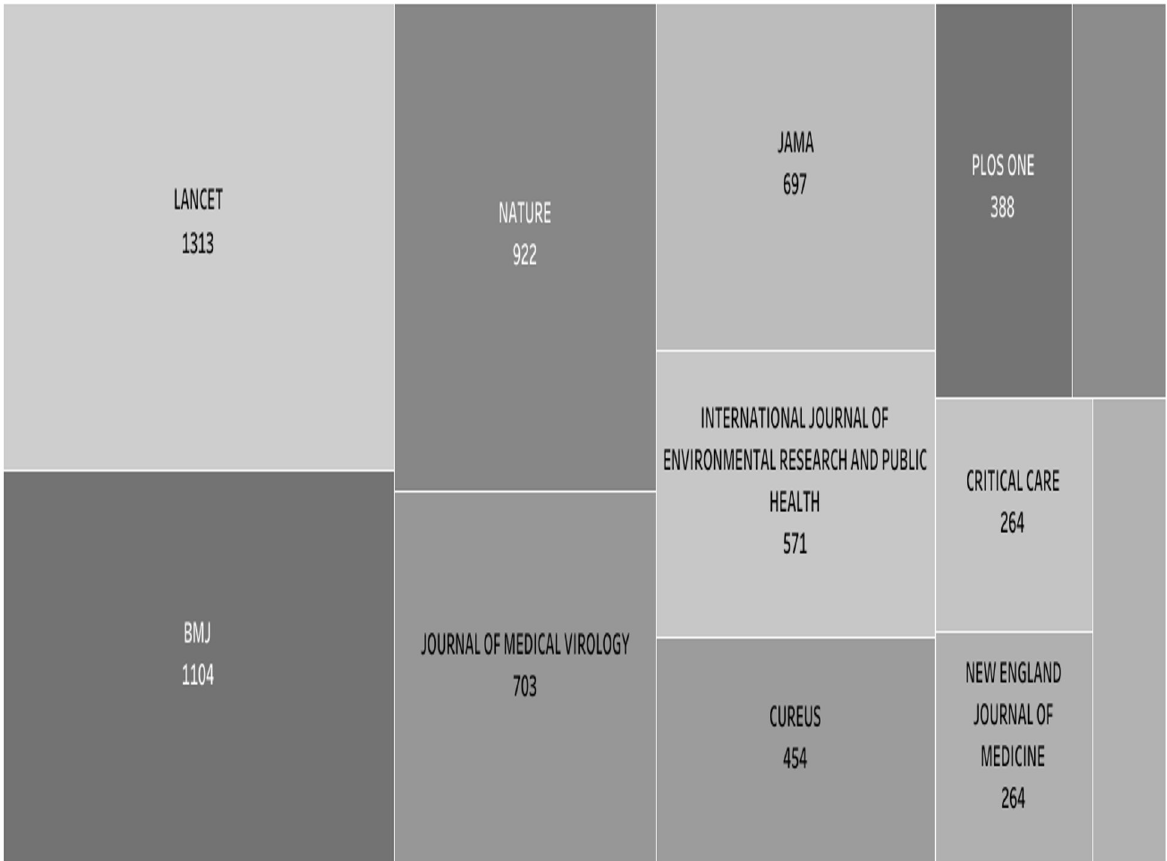
Figure 4. Output of scientific articles related to COVID-19 by the most productive journals.